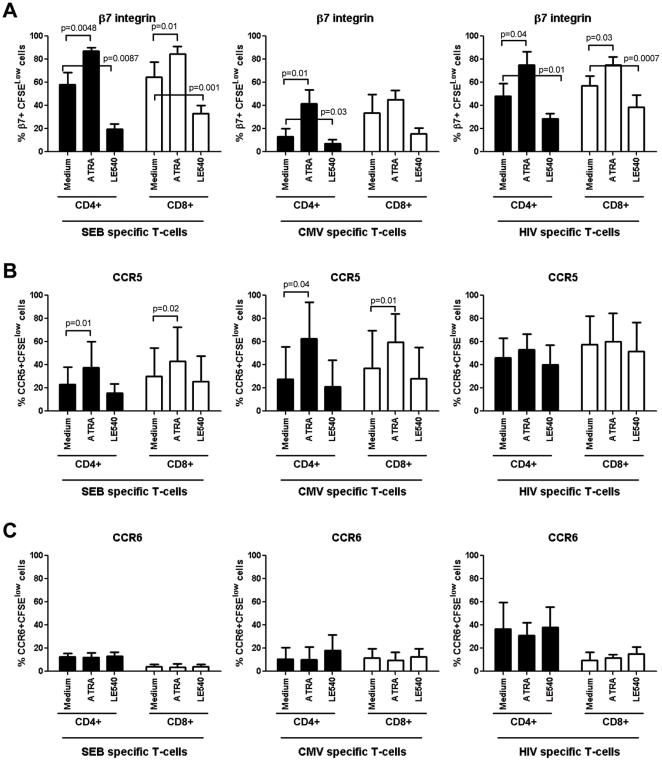
Retinoic acid activation pathway regulates integrin β7 expression on HIV-specific T-cells.PBMC from SP subjects were loaded in CFSE (0.5 µM) and stimulated with HIVNef-Gag-Pol peptide pool (500 ng/ml), SEB (25 ng/ml), or the recombinant CMV-pp65 peptide pool (1 µg/ml) for 6 days at 37°C in the presence or absence of all-trans-retinoic acid (ATRA; 10 nM) or the RA antagonist LE540 (1 µg/ml). Cells were stained with a cocktail of fluorochrome-conjugated CD3, CD4, integrin β7, CCR5 or CCR6 Abs and analyzed for the expression of (A) integrin β7, (B) CCR5, and (C) CCR6 on CFSElow CD4+ and CD8+ T-cells specific for SEB, CMV, and HIV antigens. Experiments were performed with cells from four SP subjects (mean±SD). Paired t-Test p-values are indicated in the figures.